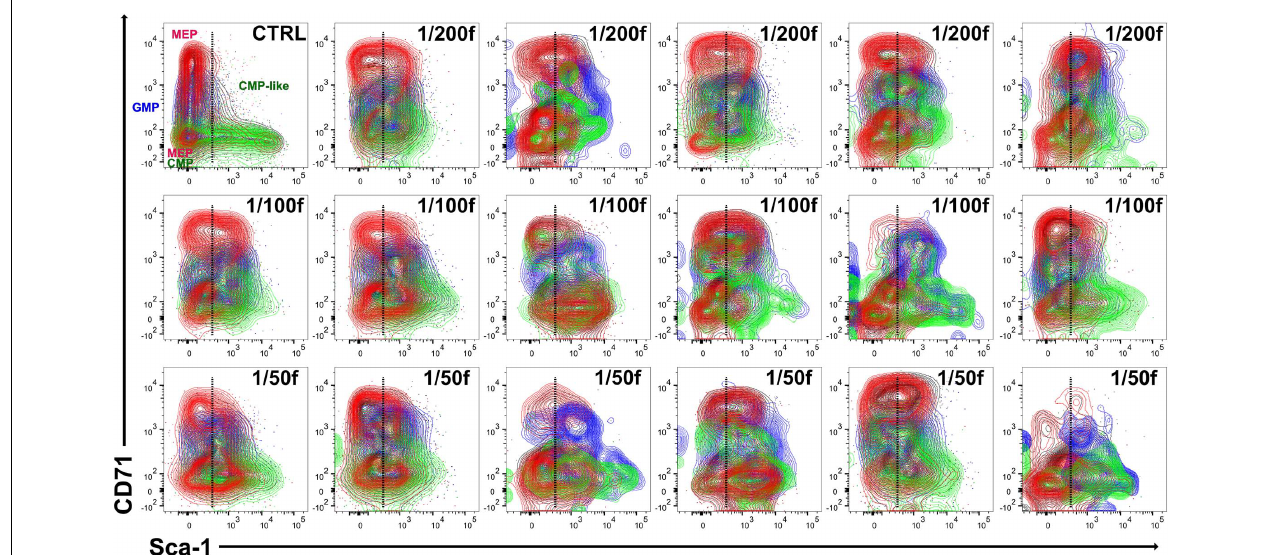
FIGURE 3 | The variable cell clusters of LK cells in regenerating bone marrow have immunophenotype corresponding to CMP, GMP, and MEP progenitors in the normal bone marrow. LK cells in one control mouse (CTRL) and 17 irradiated and transplanted mice (all females) analyzed in Figure 2 were stained for the CD34 and CD16/32 markers correspondingly to CMP (green), GMP (blue), and MEP (red) progenitors known in normal bone